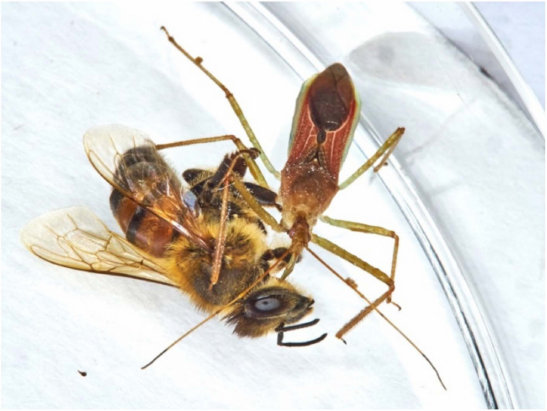
Figure 18. LAB female feeding on the single killed AM worker.